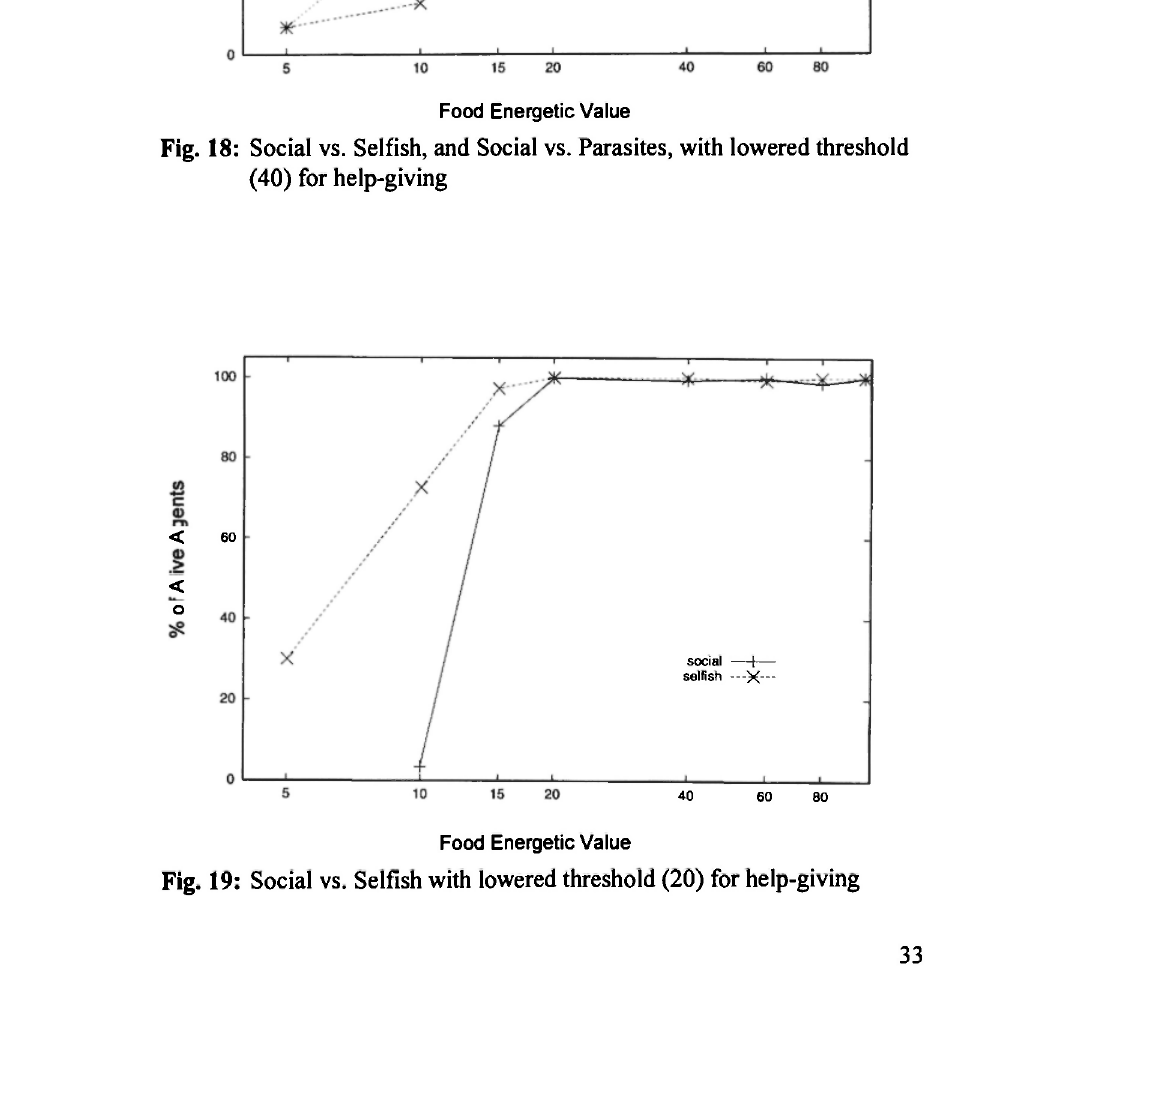
Fig. 18: Social vs. Selfish, and Social vs. Parasites, with lowered threshold (40) for help-giving